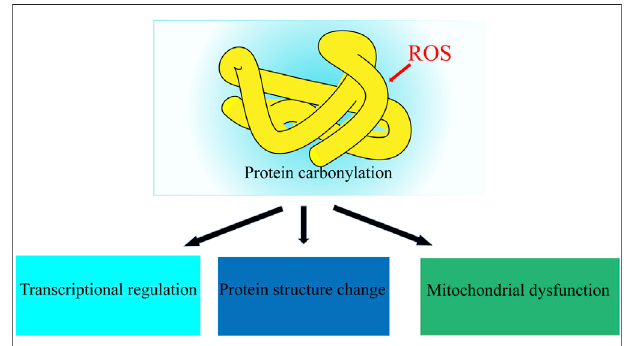
FIGURE 4 | Oxidative Protein Damage. ROS leads to abnormal protein structure and